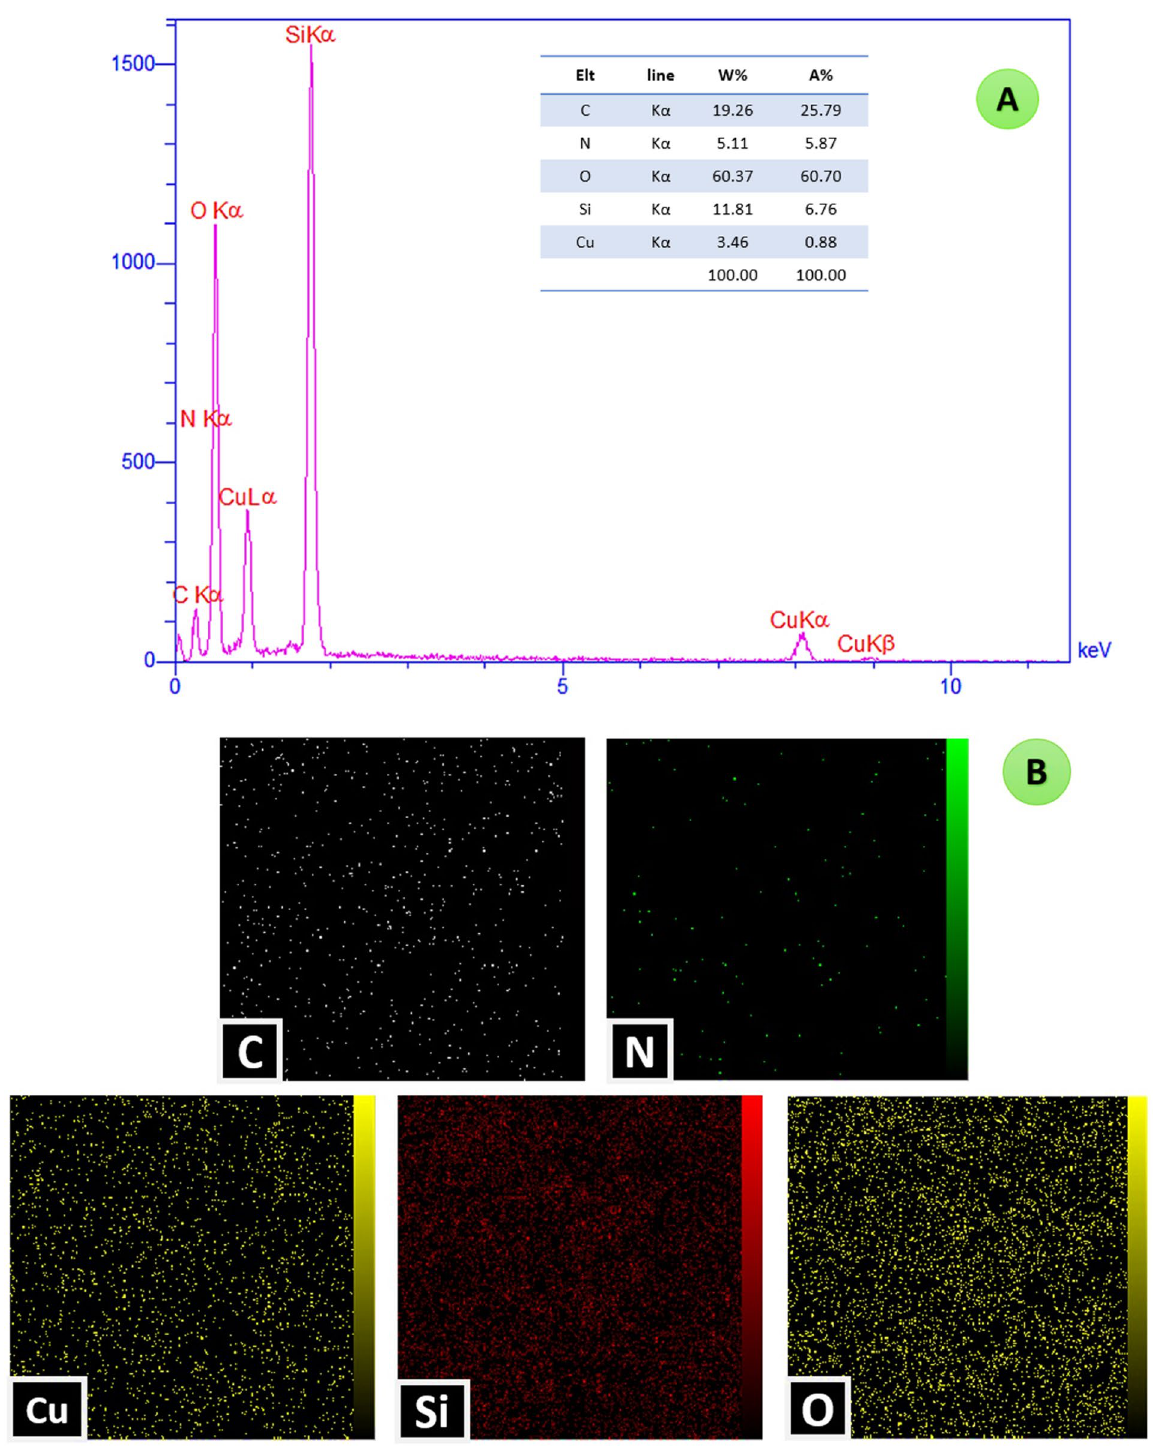
Figure 5. The EDX analysis and mapping images of the Cu@MCM-41-HPr-Met